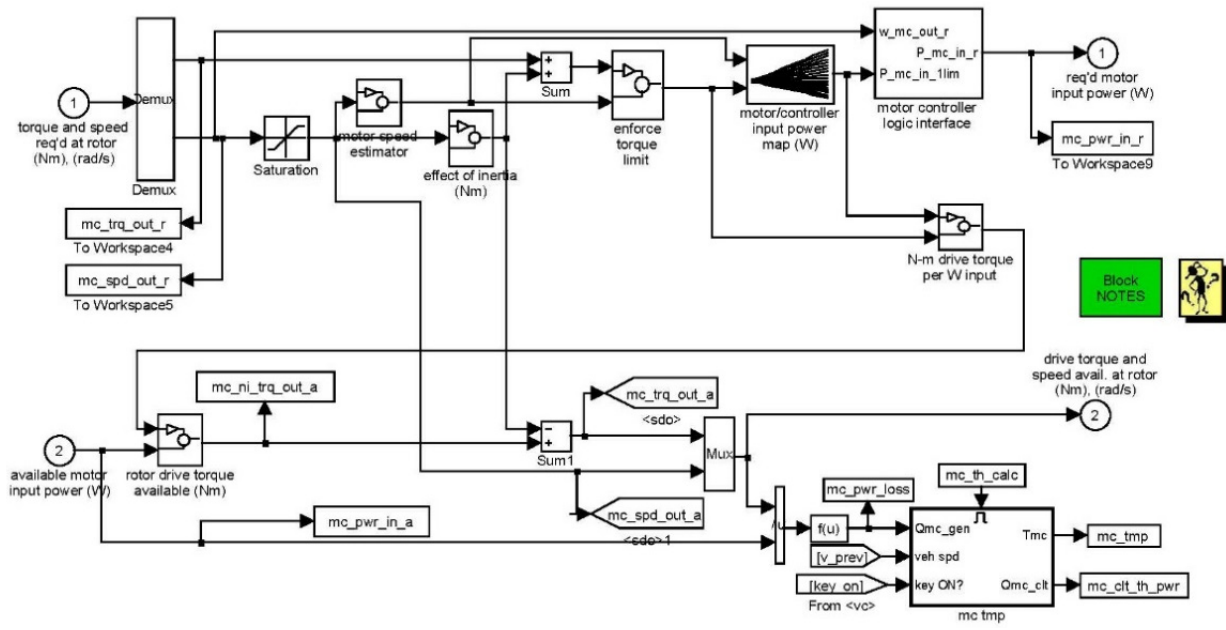
Figure 5. Top-level model diagram of the motor module.